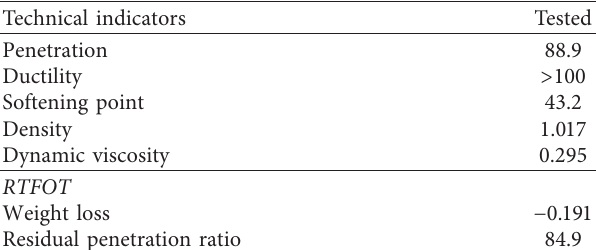
Table 1: Technical indicators of AH-90.